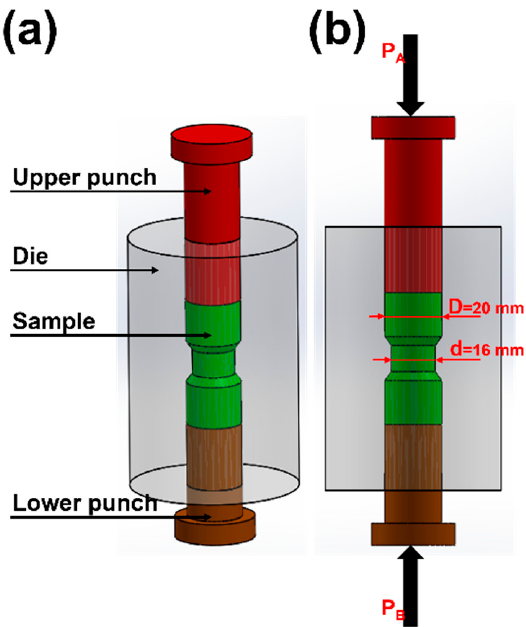
Figure 1. Schematic representation of the cyclic extrusion compression (CEC) process: ( a ) the three-dimensional view of the significant die parameters and ( b ) the front view of the CEC process, with an initial diameter and extruded diameters, along with applied pressures.